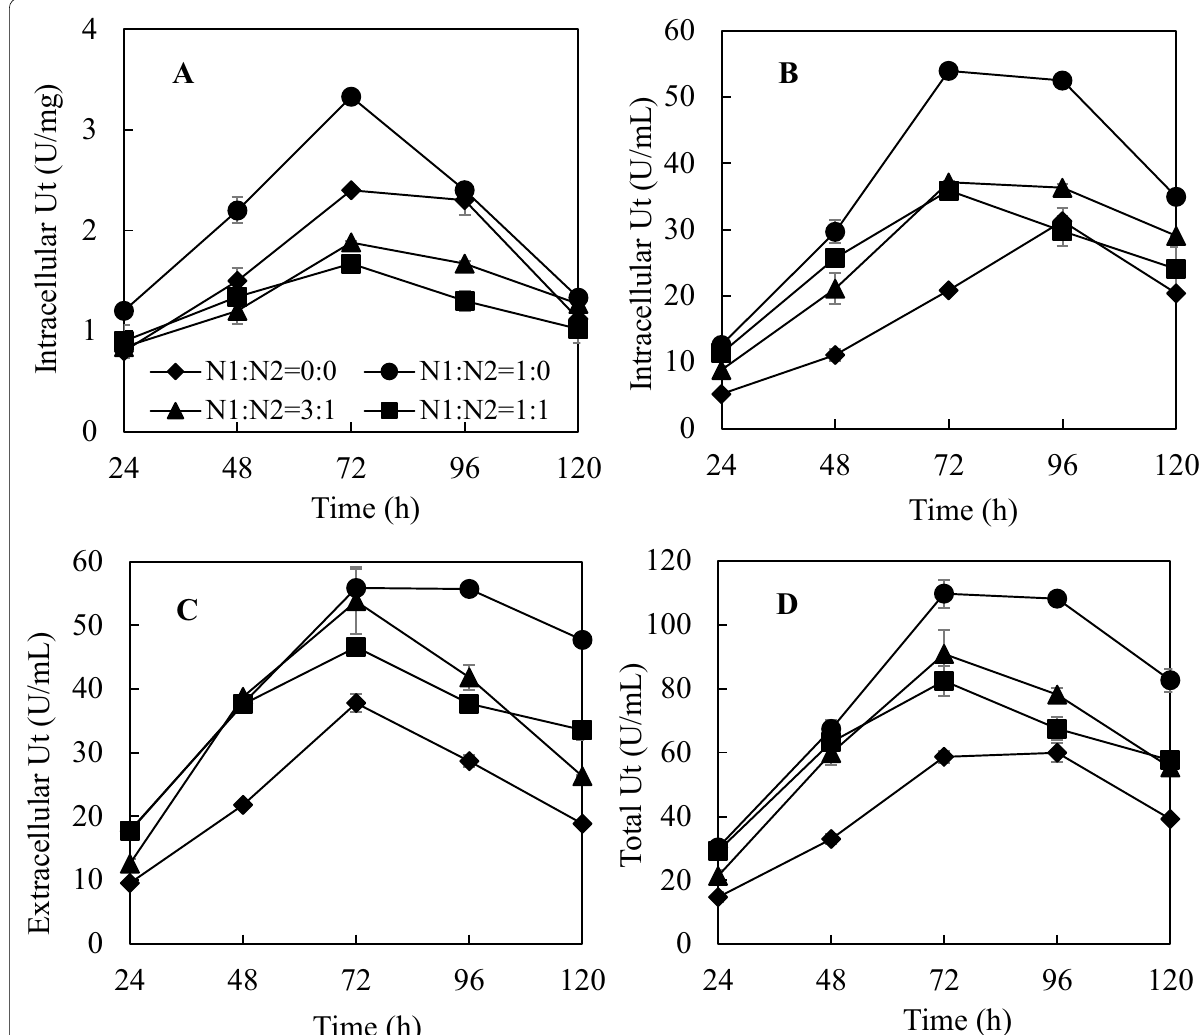
Fig. 2 Effect of nitrogen source ratio on specific intracellular transfructosylating activity ( A ), and intracellular ( B ), extracellular ( C ), and total ( D ) enzyme activities based on per unit of volume. N1—NaNO3 nitrogen, N2—yeast extract nitrogen; total levels of N and P shown in Table 1